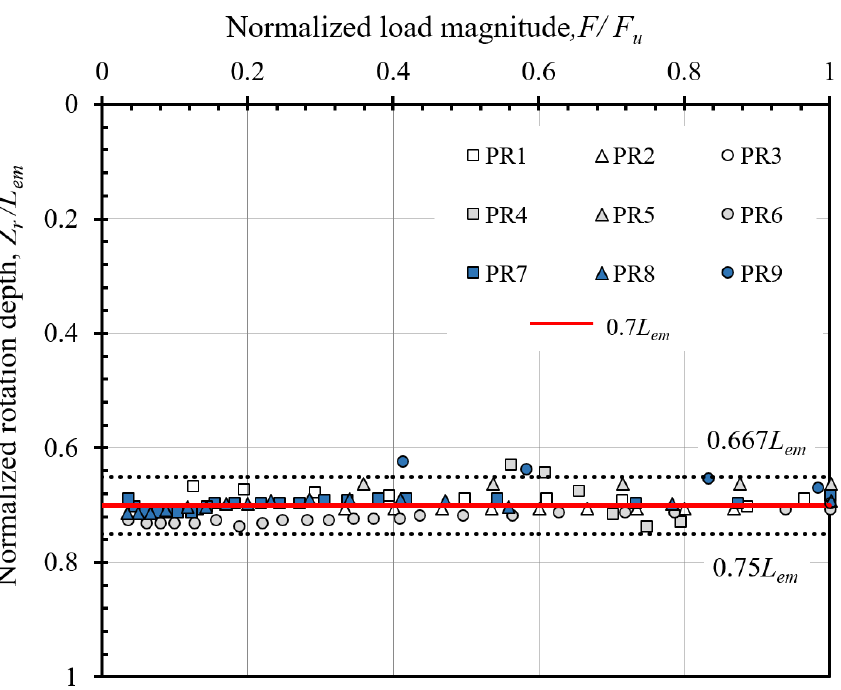
Figure 2. Variation of normalized rotation point depth for rigid pile in cohesive soil.